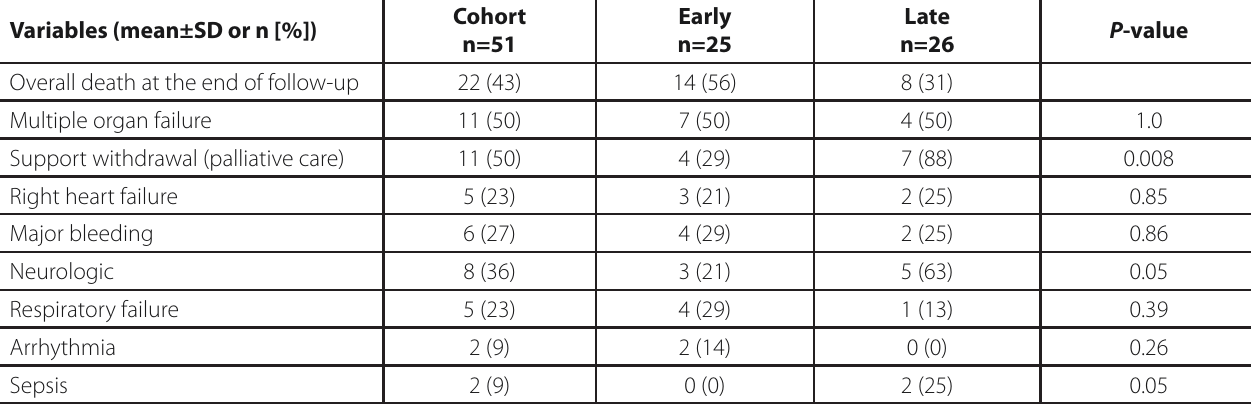
Table 4. Contributing causes of death in patients by treatment era.